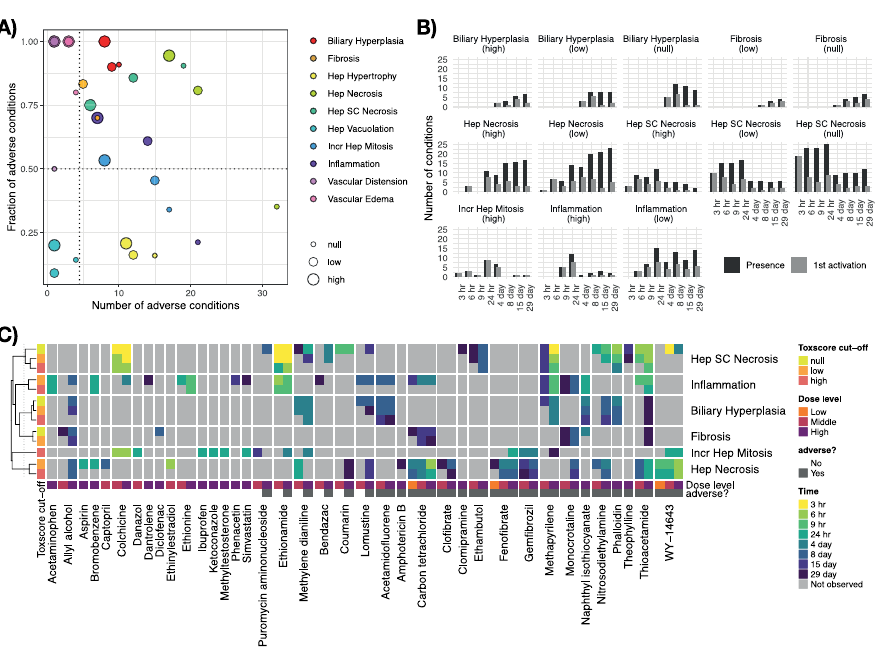
Fig 3. Distribution and relation of histopathological findings across time series. A) Histopathology labels are defined for each histopathological finding at 3 different toxscore cut-offs, namely “null” (toxscore > 0), “low” (toxscore > 0.67) and “high” (toxscore > 1.34). For each label, the number of occurrences in the 40 adverse time series and the fraction of adverse time series among all occurrences of the given histopathology label are shown. Histopathological findings, out of which at least 50% and at least 5 of the occurrences were found in adverse conditions timeseries were considered adverse B) Number of conditions with histopathological findings at different timepoints, as well as the frequency of the respective first activations C) Time of first activation across timeseries labelled as adverse or non-adverse. Each time series is annotated with the dose level in repeat-dose studies, as well as with whether or not the time series was considered adverse by Sutherland et al.